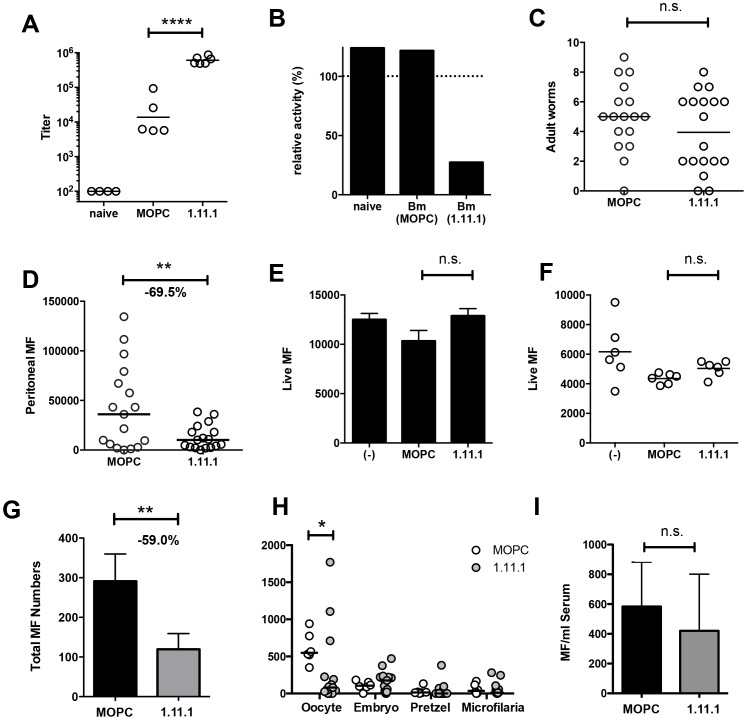

In vivo Bm-TPI blockade reduced microfilarial production by adult females.
A. Serum titers of anti-Bm-TPI antibodies following multiple injections (16×) with 1.11.1 anti-Bm-TPI mAb or control IgG1 myeloma protein MOPC31C in mice 28 days following transplant of adult B. malayi worms. Representative of two experiments. **** p<0.0001 by ANOVA. B. Ability of serum from recipient mice to neutralize Bm-TPI activity. Sera were compared from naïve mice or day 28 post-Bm adult implant mice treated with MOPC or 1.11.1 anti-Bm-TPI mAb as (A). Dotted line indicates enzyme activity in absence of serum. C. Day 28 peritoneal worm burdens in recipients of MOPC31C or 1.11.1 anti-Bm-TPI Mab as (A). D. Day 28 peritoneal microfilarial counts in recipients of MOPC31C or 1.11.1 anti-Bm-TPI Mab as (A). Data in C and D are combined results from 3 independent experiments, with 5–6 mice per group. ** p<0.01 by t-test. E. Live MF numbers following 3 day in vitro culture alone, with MOPC31C or with 1.11.1. Initial MF input was 15,000 and data is from 3–4 wells per treatment, and is representative of two experiments. F. Live MF numbers recovered from individual female worms obtained from the peritoneal cavity of untreated jirds. Worms were cultured for 2 days alone, with MOPC31C or with 1.11.1, and is representative of two experiments. G. Live Mf numbers by individual female worms (2 day cultured) obtained from the peritoneal cavity of mice injected multiple times with MOPC31C or with 1.11.1. for 14 days. * p<0.05 by Mann-Whitney. Data are pooled from two independent experiments. H. Embryogram of uterine contents of individual adult female B. malayi parasites recovered from peritoneal cavity of mice (n = 4) injected multiple times for 14 days with MOPC31C or 1.11.1 anti-TPI antibody. I. Microfilarial numbers in blood 24 hours following i.v. transfer into mice receiving control MOPC31C and 1.11.1 anti-TPI antibodies.